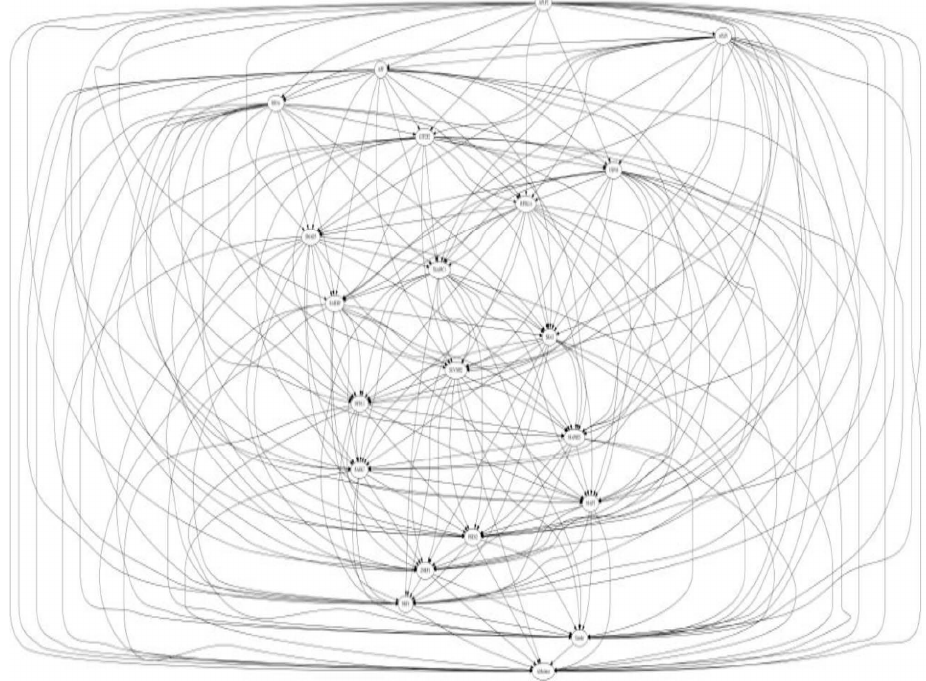
Figure 12. Bene network showing gender and NRF1 association with AD in hippocampal microarray [272].